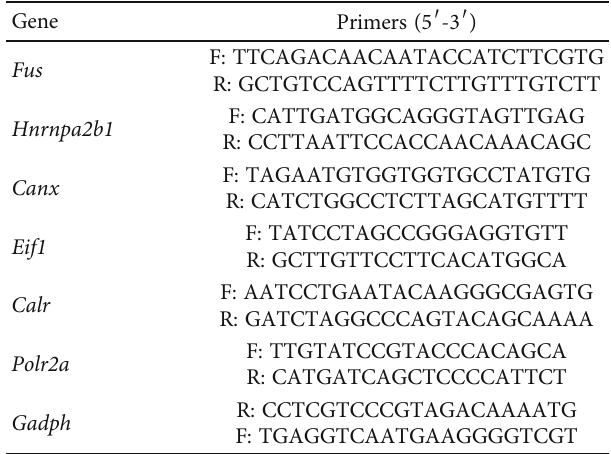
Table 1: Primers for qRT-PCR